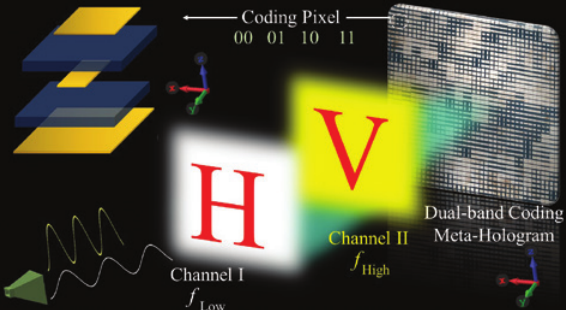
Figure 1: The schematic sketch of the dual-band coding elements as well as the proposed coding meta-hologram creating two different information channels at the lower and higher working frequency bands upon illuminating by normal plane waves. Different images (“H” and “V”, here) can be simultaneously projected in these near-field